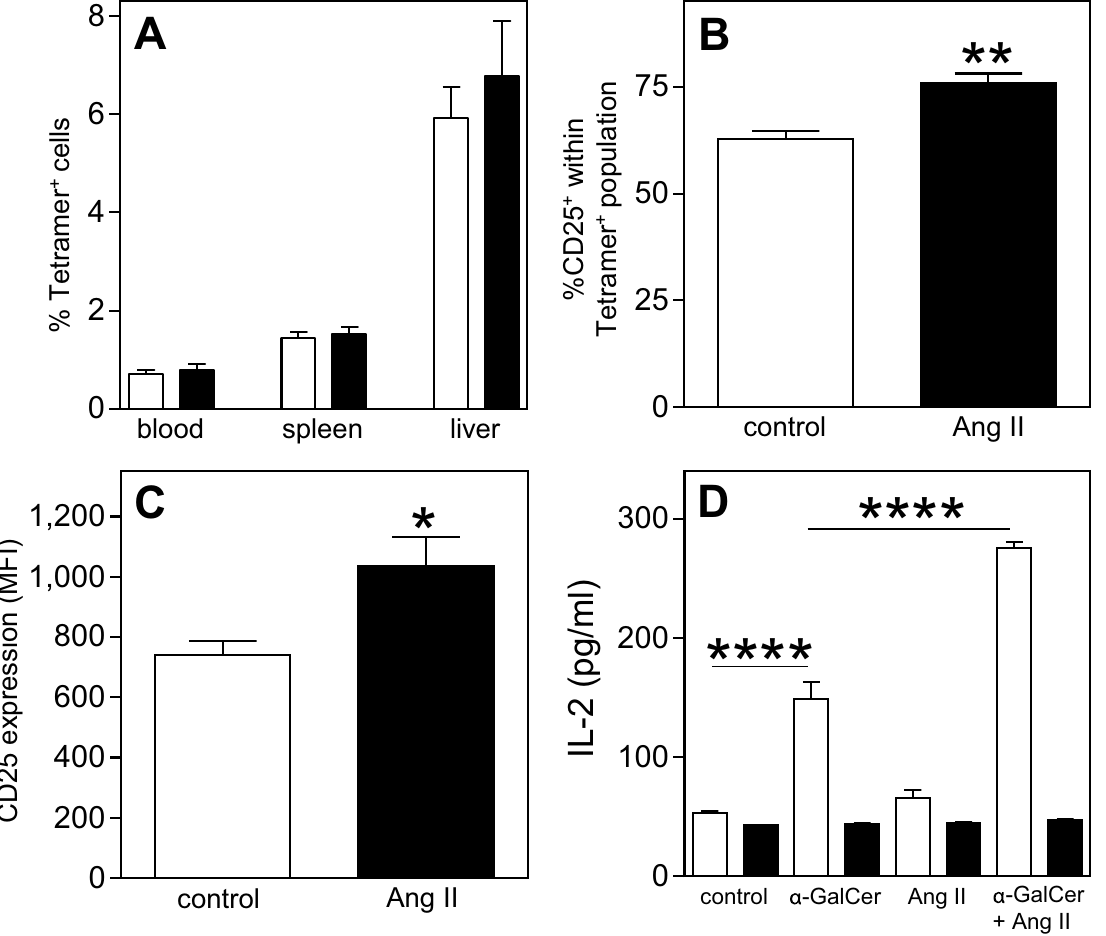
Fig 3. Increased NKT cell activity upon angiotensin II treatment. Osmotic pumps filled with PBS (n = 5) or Ang II (n = 5) were implanted in LDLr -/- mice fed a Western type diet for 1 week. Two weeks after pump placement, the mice were sacrificed and the percentage of NKT (Tetramer + ) cells in spleen and liver (A, white bars represent PBS treated mice, black bars Ang II treated mice) and the activation status of splenic NKT cells (B and C) were determined by FACS analysis. To confirm these effects, antigen-presenting cells (APCs) isolated from bone marrow of LDLr -/- (white bars) and LDLr -/- CD1d -/- mice (black bars) were incubated with α -GalCer, AngII or a combination of both. Four hours after incubation, the APCs were co- cultured with DN32.D3 hybridoma cells. After 24 hours, the IL-2 concentration in the supernatant was determined (D). All values are mean±SEM and statistical analysis was performed using the unpaired two-tailed student’s T-test (A-C) or one-way ANOVA (D) (cid:3) P < 0.05, (cid:3)(cid:3) P < 0.01, (cid:3)(cid:3)(cid:3)(cid:3) P < 0.0001.